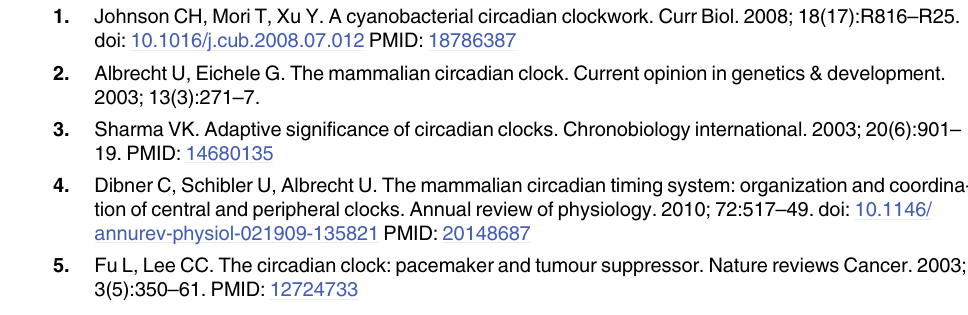
S2 Fig. MeCP2 absence impairs MeCP2-target genes circadian expression.